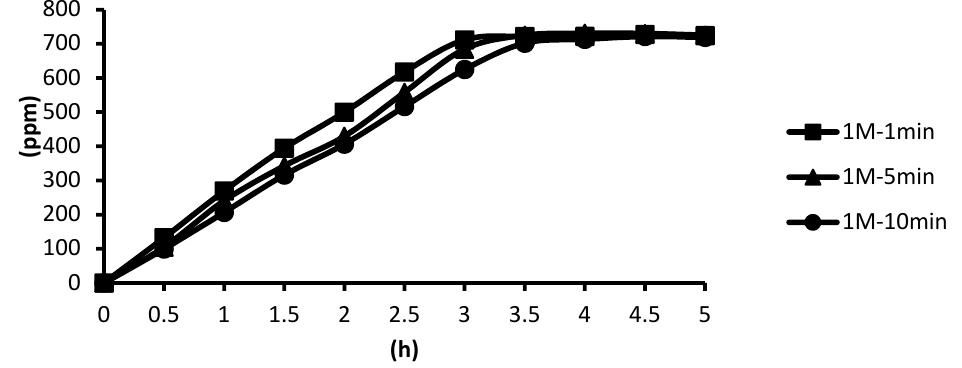
Figure 17. The effect of cross-linking time by 1 M ZnCl 2 on releasing of tea tree essential oil from alginate/tea tree essential oil microcapsules in the hot spring water.